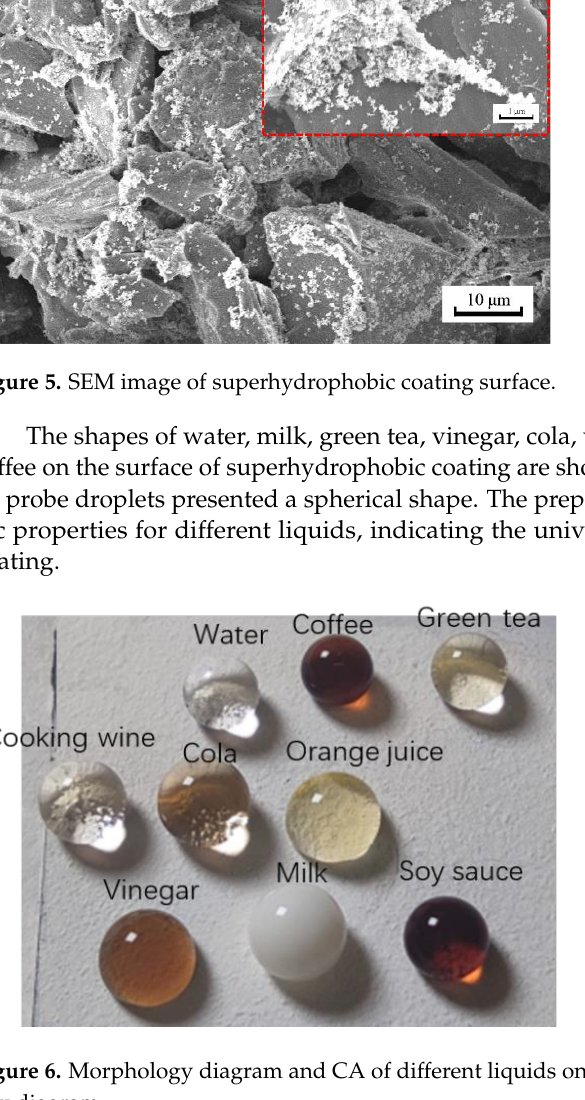
Figure 5. SEM image of superhydrophobic coating surface.